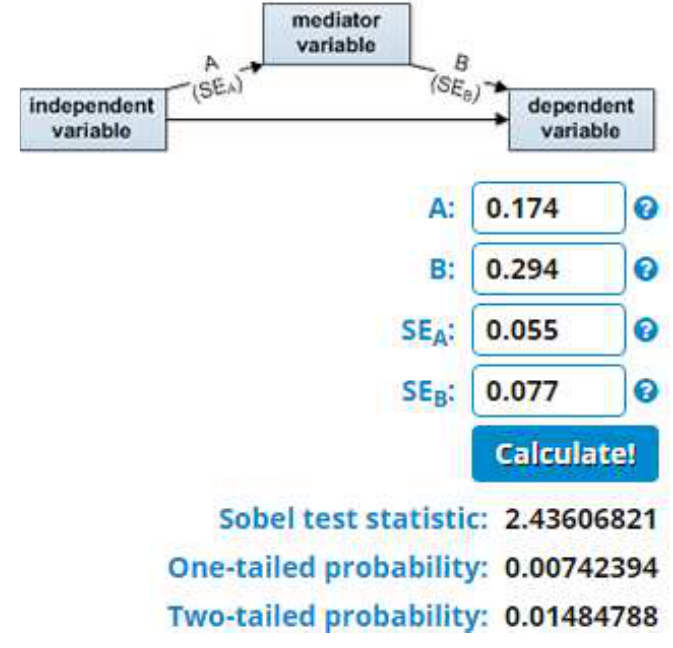
Figure 2. Sobel test